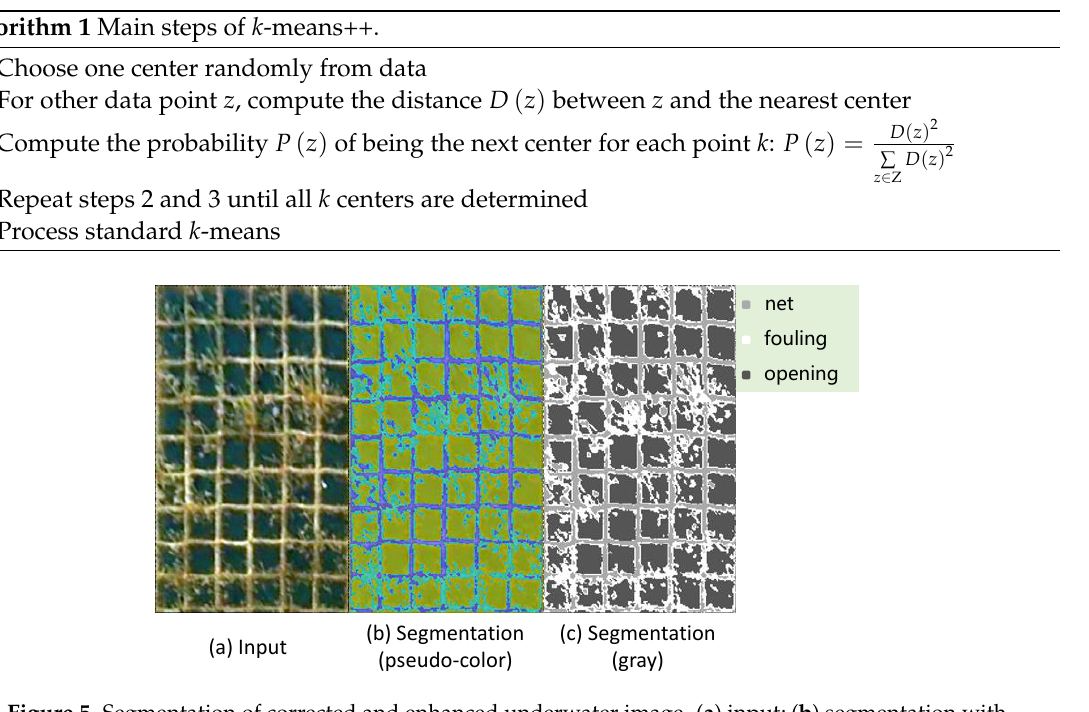
Figure 5. Segmentation of corrected and enhanced underwater image. ( a ) input; ( b ) segmentation with pseudo color; and ( c ) segmentation with